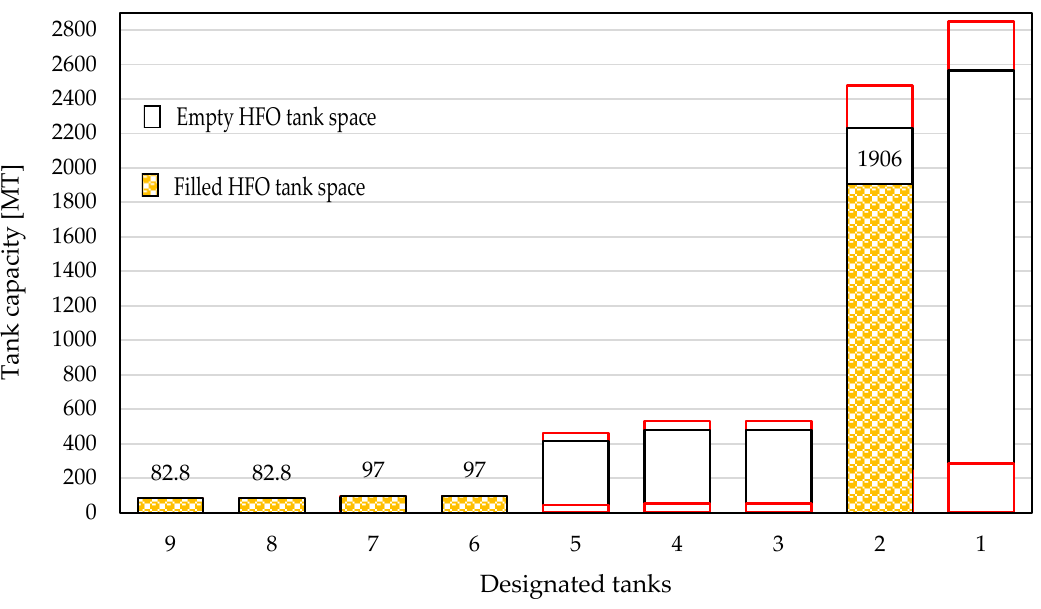
Figure 5. HFO bunker condition before bunker distribution for the second example.